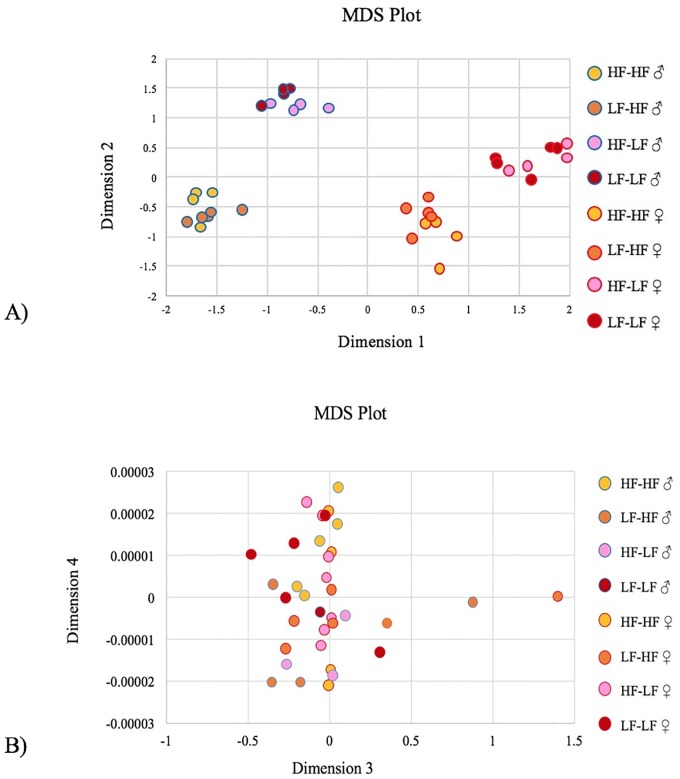
The multidimensional scaling plot.(A) Gene expression libraries clustered by sex (dimension 1) and offspring diet (dimension 2), but not maternal diet. (B) There were no discernable patterns in dimensions 3 or 4. HF = High-fat diet, and LF = Low-fat diet, N = 10 per group.